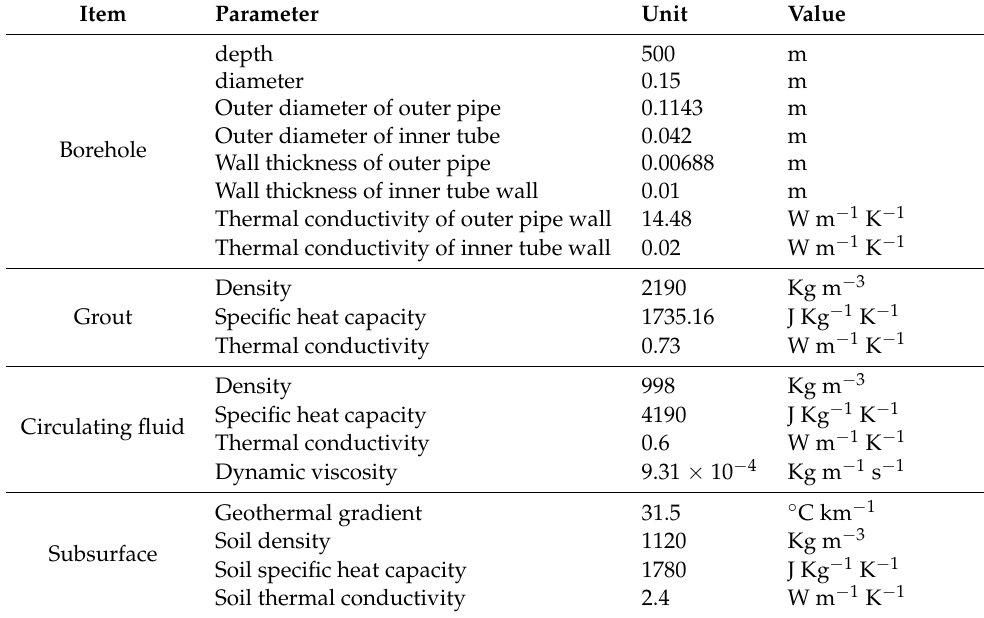
Table 1. Detailed parameters of the coaxial MSBHE